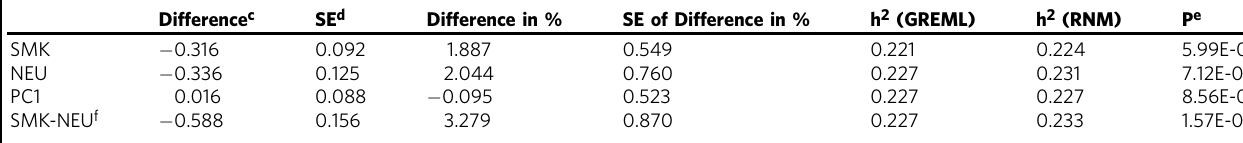
a Alternative model (H1) of M3 in Table 1 b Null model (H0) of M3 in Table 1 c Difference = the residual variance estimated from RNM − the residual variance estimated from univariate GREML d Standard error of the difference was calculated based on the theory in Supplementary Note 3 e P- value was obtained based a two-tailed Wald test using the difference of residual variances and its SE f The model jointly fi tted both SMK and NEU as multiple covariates (see